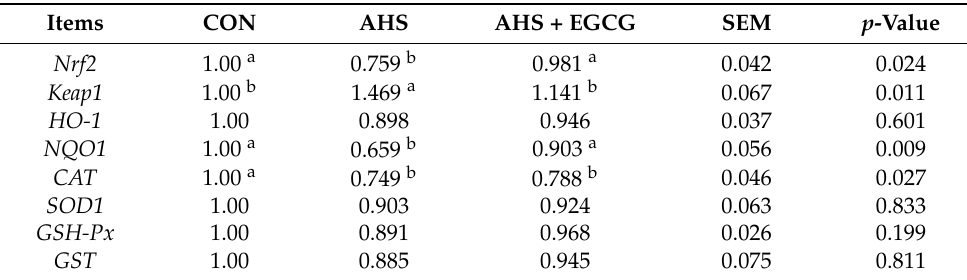
Table 6. Effect of EGCG on the expressions of Nrf2 signaling pathway related genes in the muscle of broilers subjected to acute heat